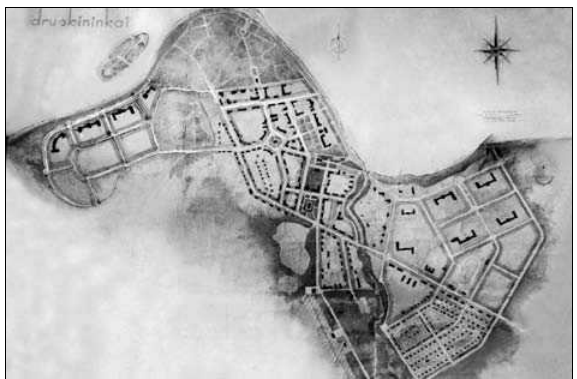
Fig. 1. Sketch of the detaled project of the central part